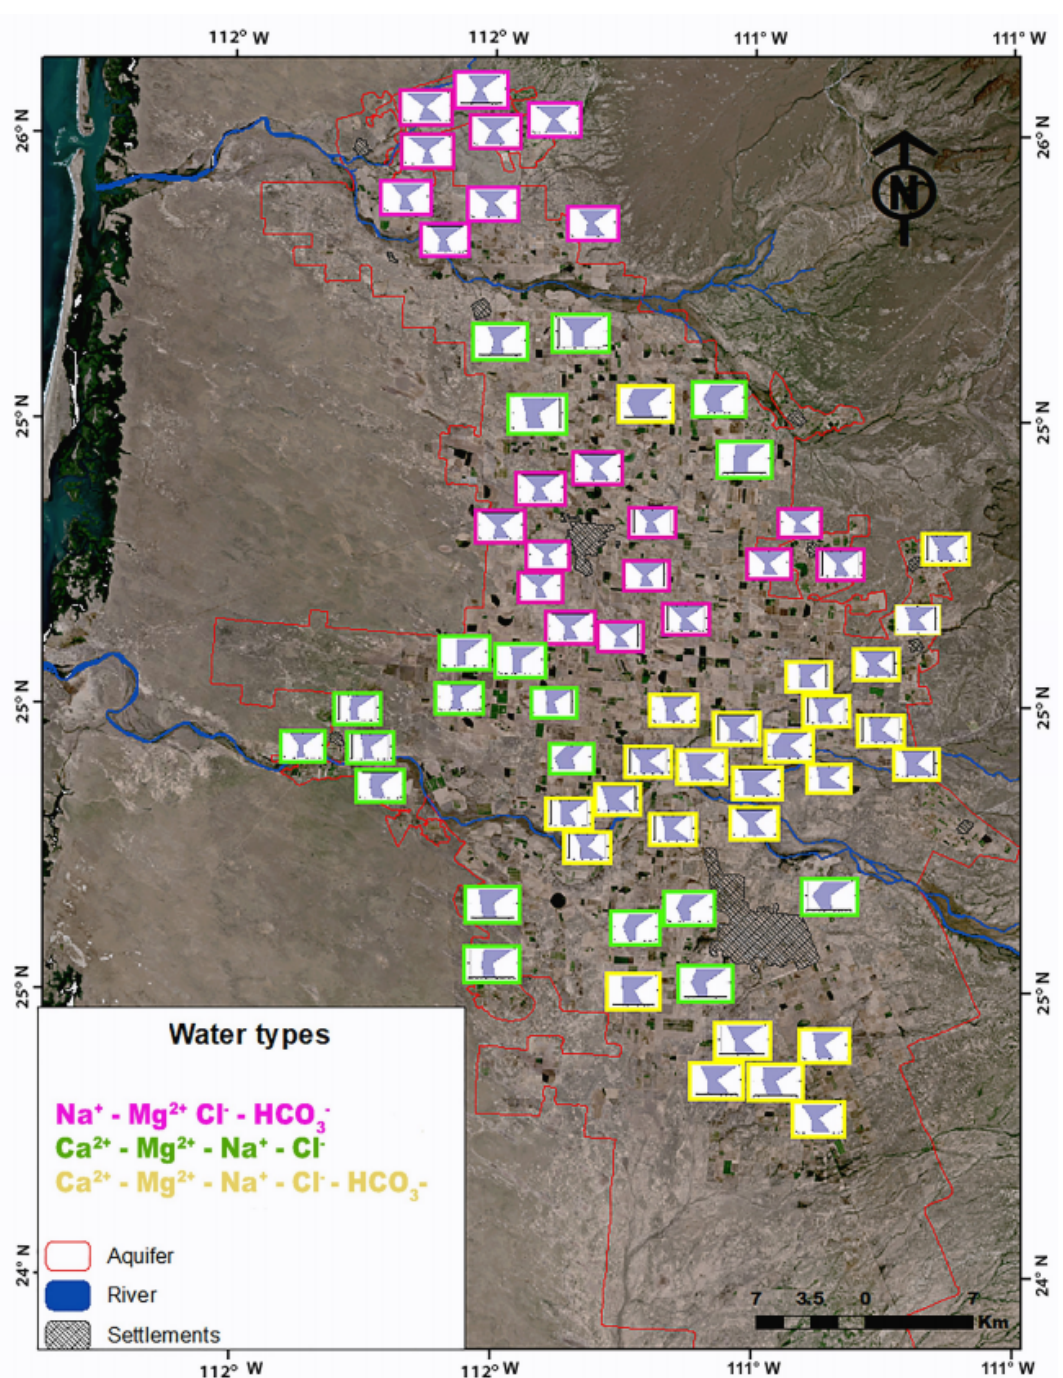
Figure 4. Spatial distribution map of the water types demonstrated by Stiff